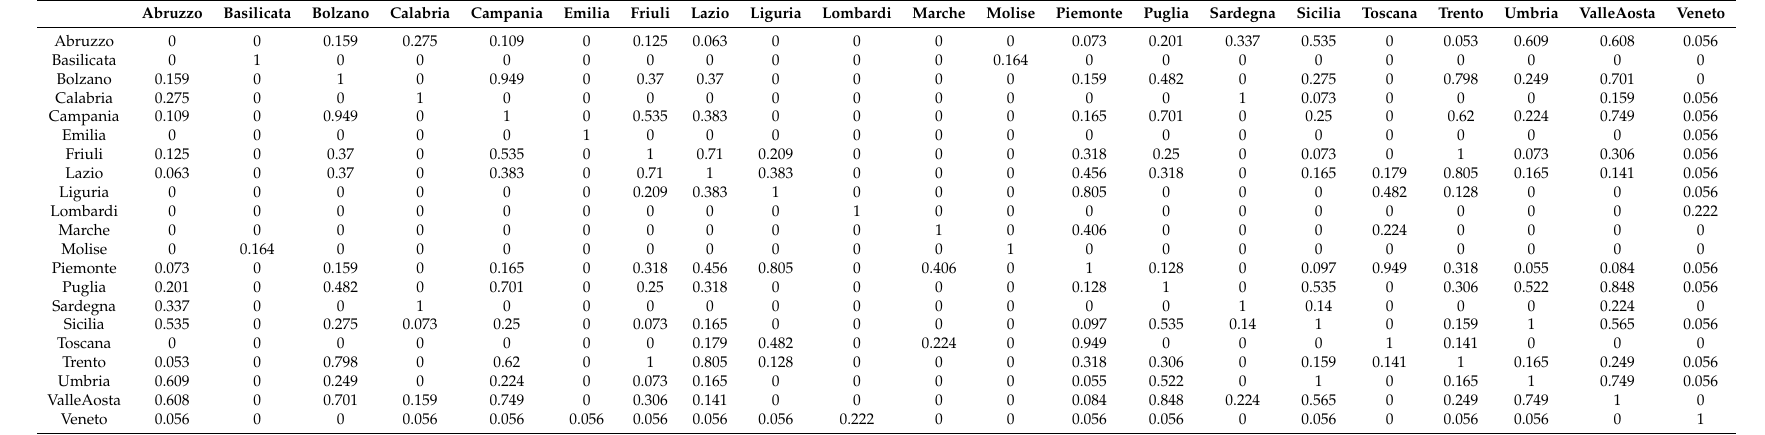
Table A34. Similarity values of New Currently Positive network in the third